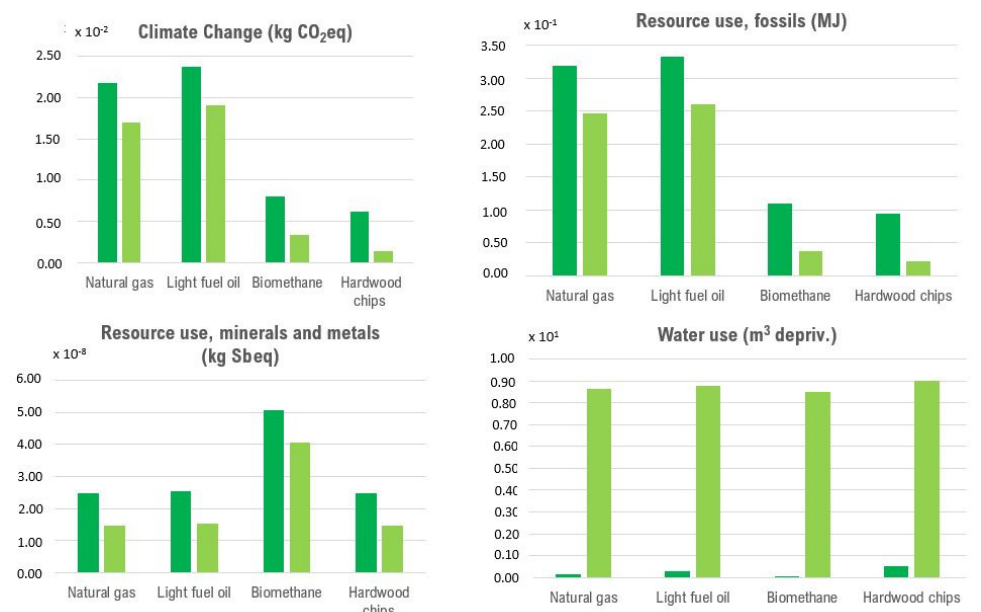
Figure 6. LCA and eLCC results for Baseline Scenario and Scenario 1 (FU: 1 kg dried material supplied by hydroelectric